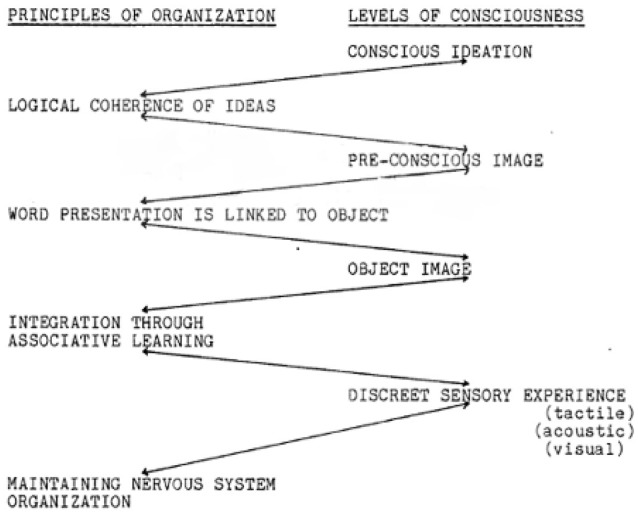
A recursive description of consciousness organized by language, after Grobbelaar (1989).